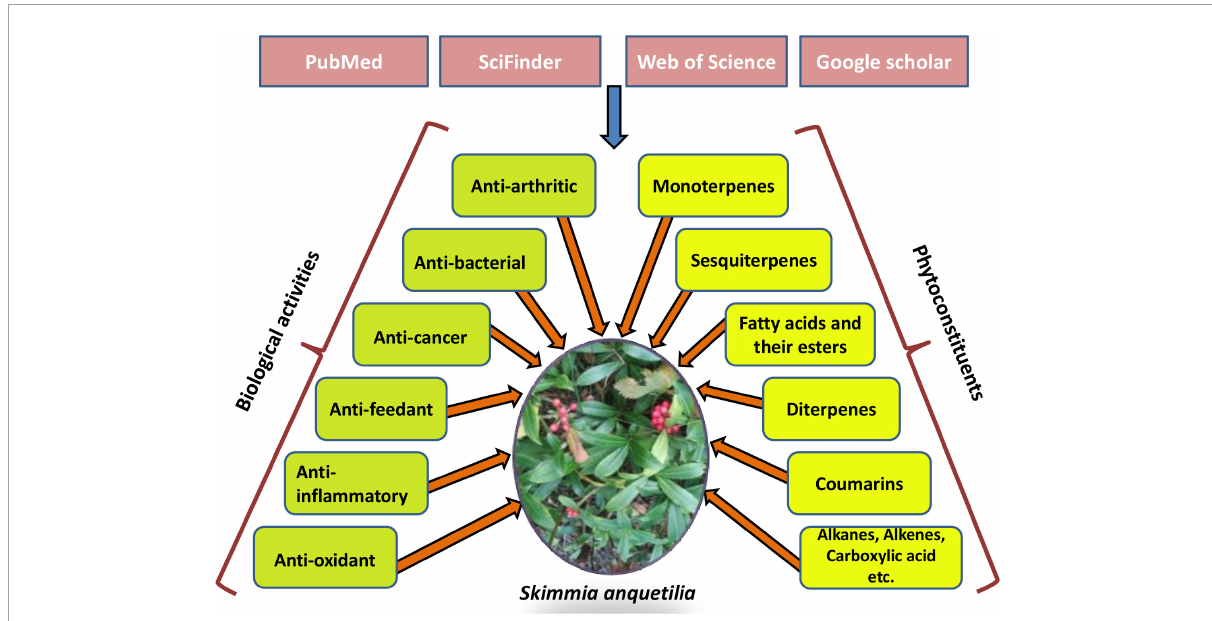
FIGURE1 Several databases used to access various phytoconstituents and pharmacological activities of Skimmia anquetilia .